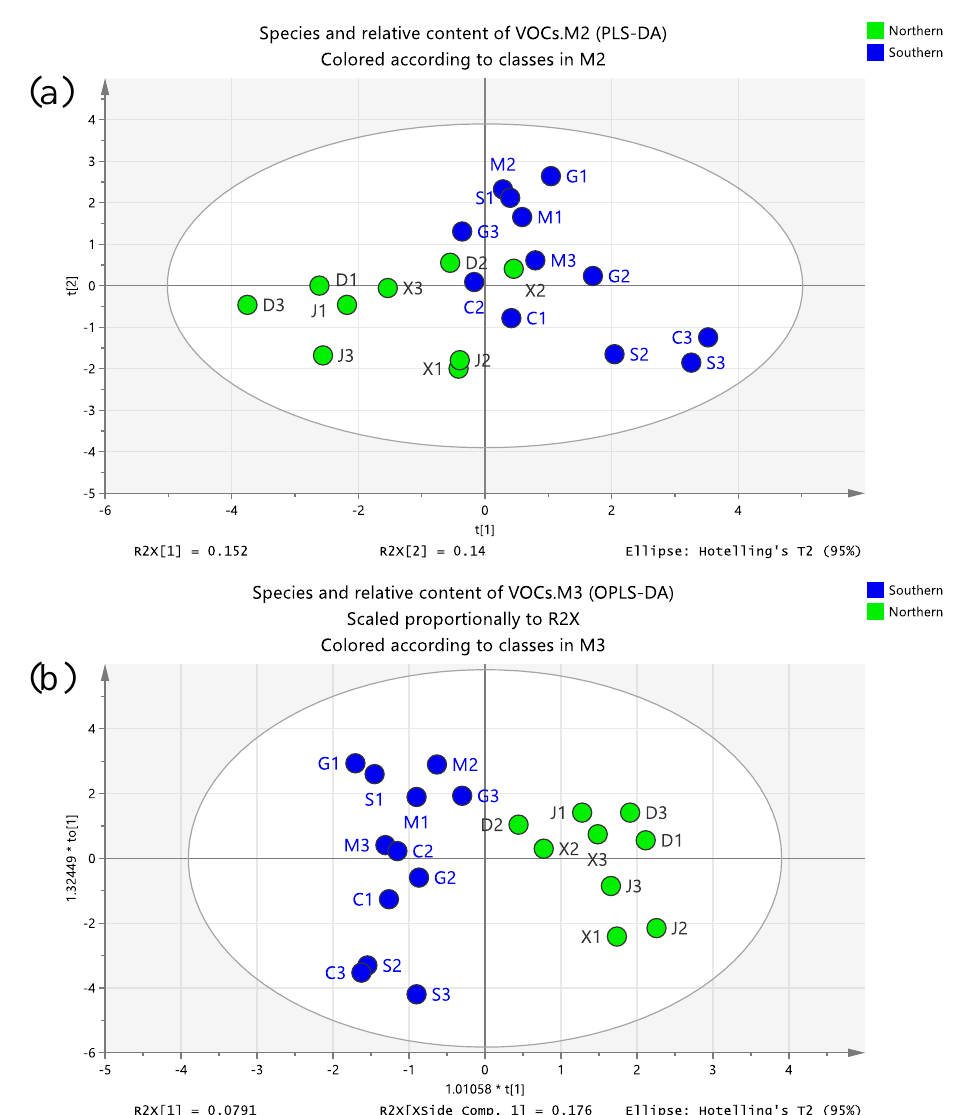
Figure 5. PCA-DA ( a ) and OPLS-DA ( b ) diagrams of northern and southern regions.